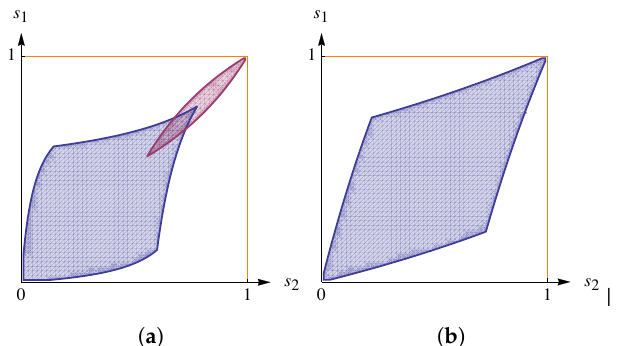
Figure A3. The blue sets in ( a , b ) depict the sets of all ESDs for G P 1 and G P 2 , respectively. The red region corresponds to all stationary distributions such that both players get more than the mutual cooperation payoff (this is possible only in G P 1